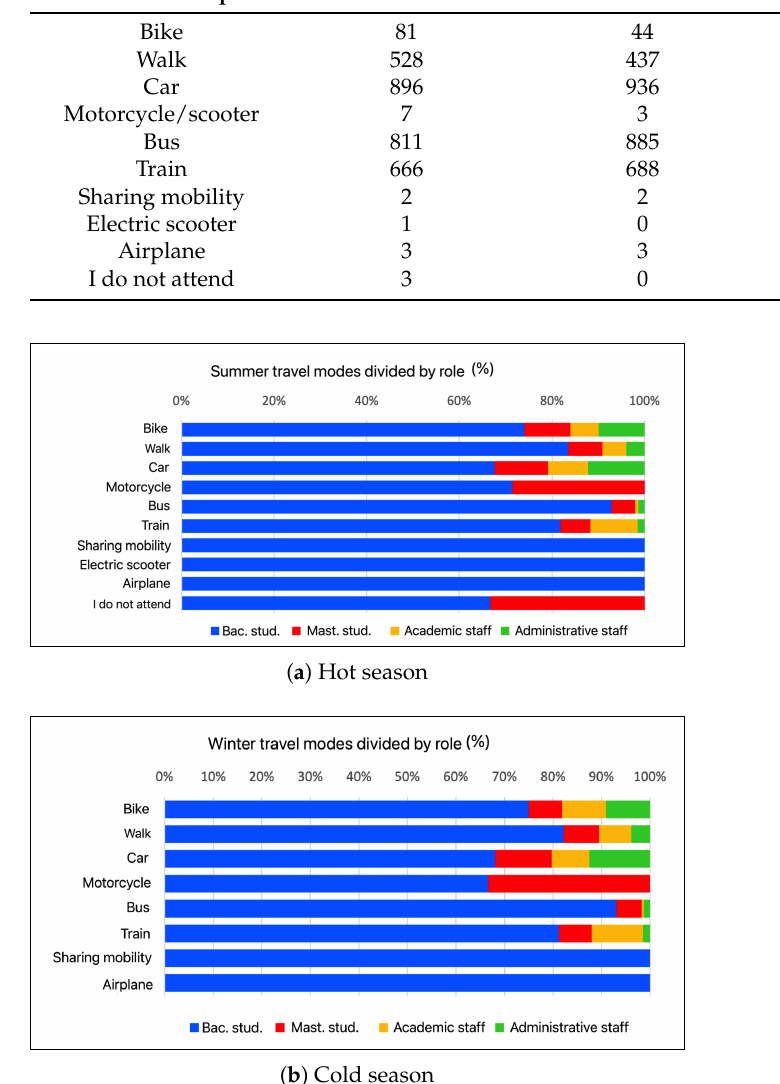
Figure 15. Travelling modes grouped by